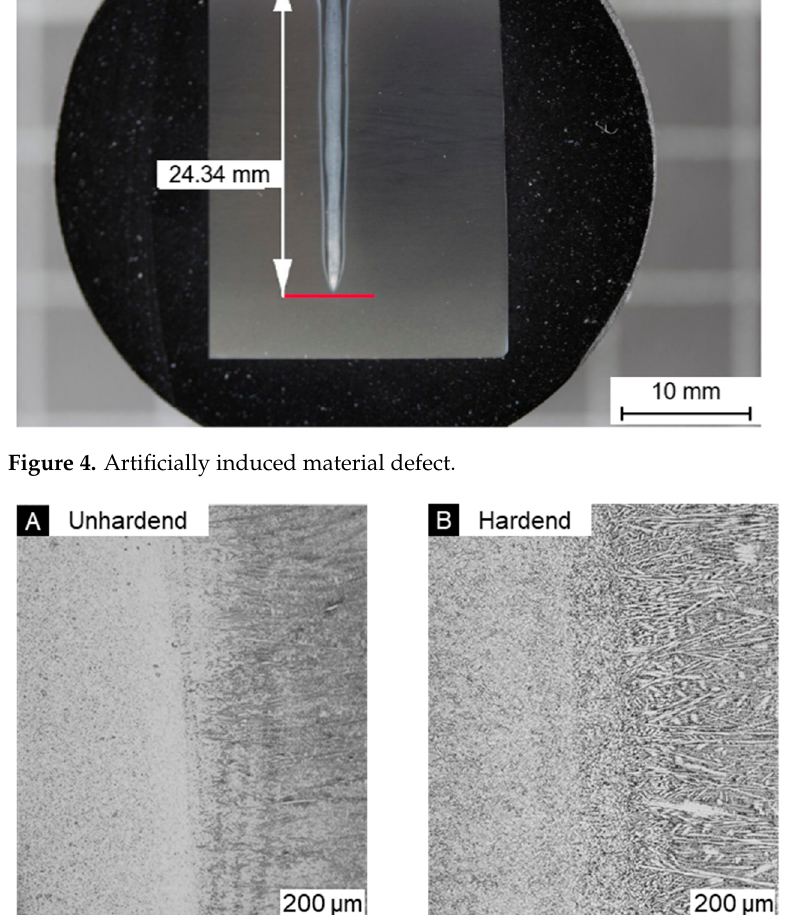
Figure 4. Artificially induced material defect.